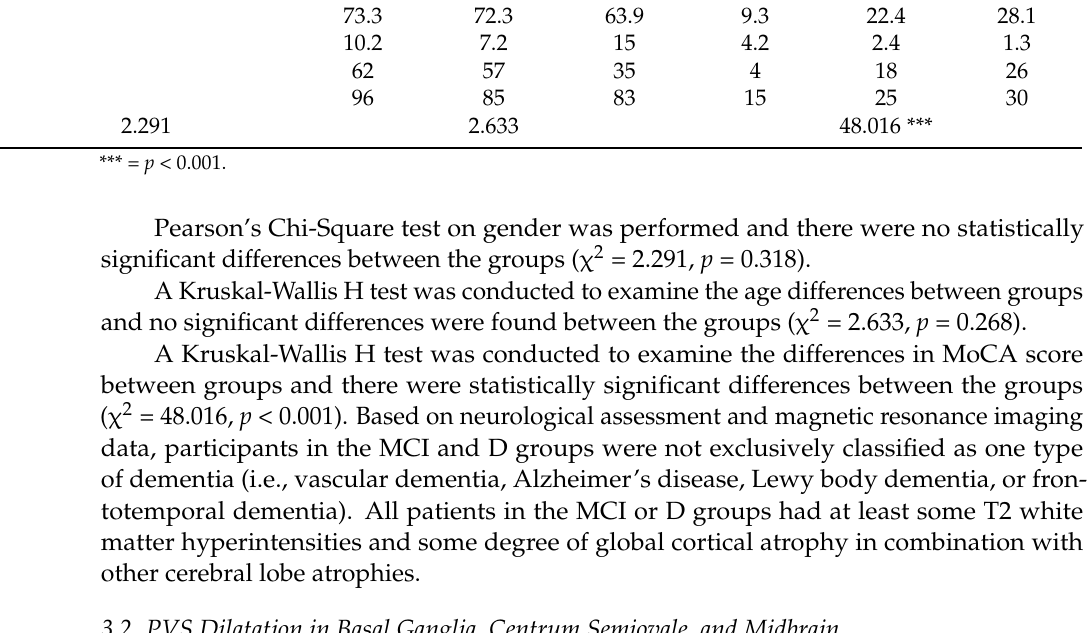
Table 2. Basal Ganglia PVS dilatation grade in dementia, MCI and normal cognition groups.